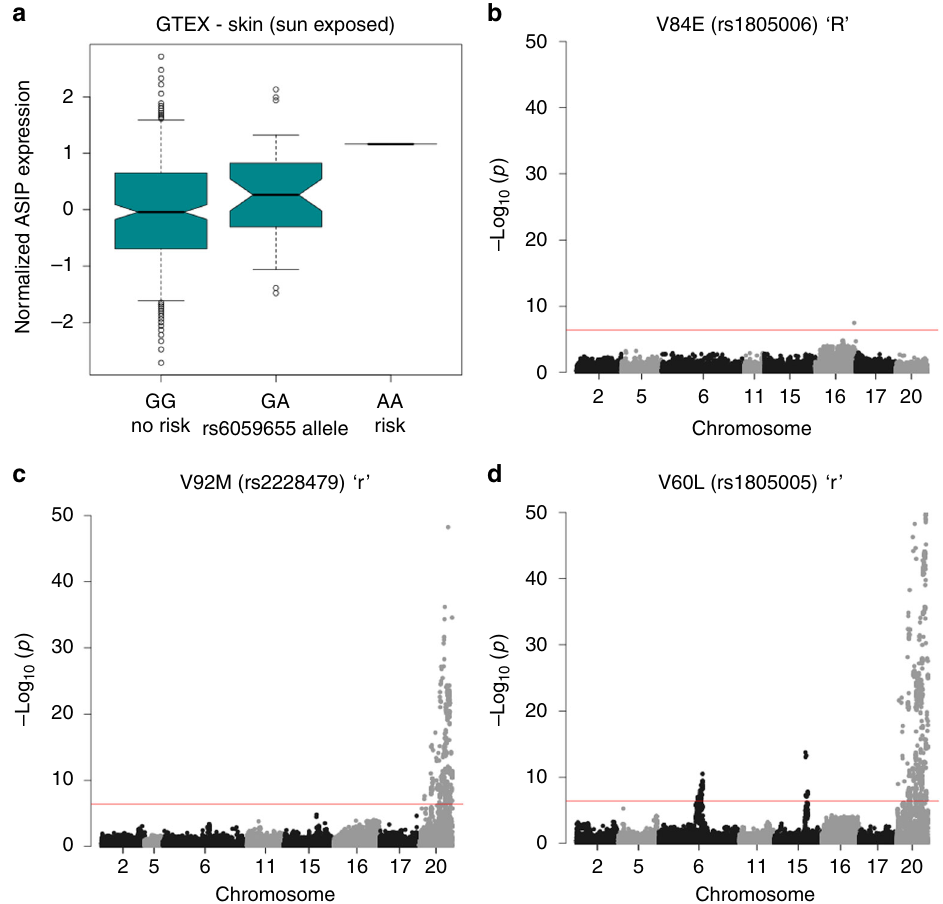
Fig. 3 Gene expression variation at ASIP and epistatic interactions with MC1R variants. a Gene expression data from GTex of ASIP in sun-exposed skin, ordered by genotype at rs6059655 and normalised to the homozygous no-risk genotype (GG). Boxplot indicates the median expression of ASIP, and the error bars indicate 95% of the data in 320 individuals, 277 with no-risk allele, 42 with middle risk allele and 2 with the high risk allele. b − d Epistatic interactions between MC1R coding variants and other red-hair-associated loci. b The high penetrant allele D84E shows no trans interactions, c the low penetrant allele V92M shows interactions at ASIP , d the low penetrant allele V60L shows interactions with ASIP , HERC2/OCA2 and